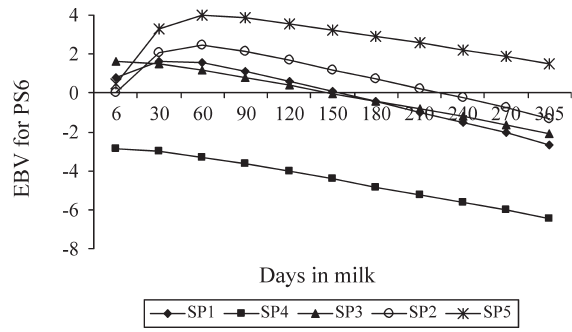
Figure 7 - Estimated breeding values across lactation of the top five sires (SP1-SP5) with more than 25 daughters ranked for persistency of lactation (PS 6 ).